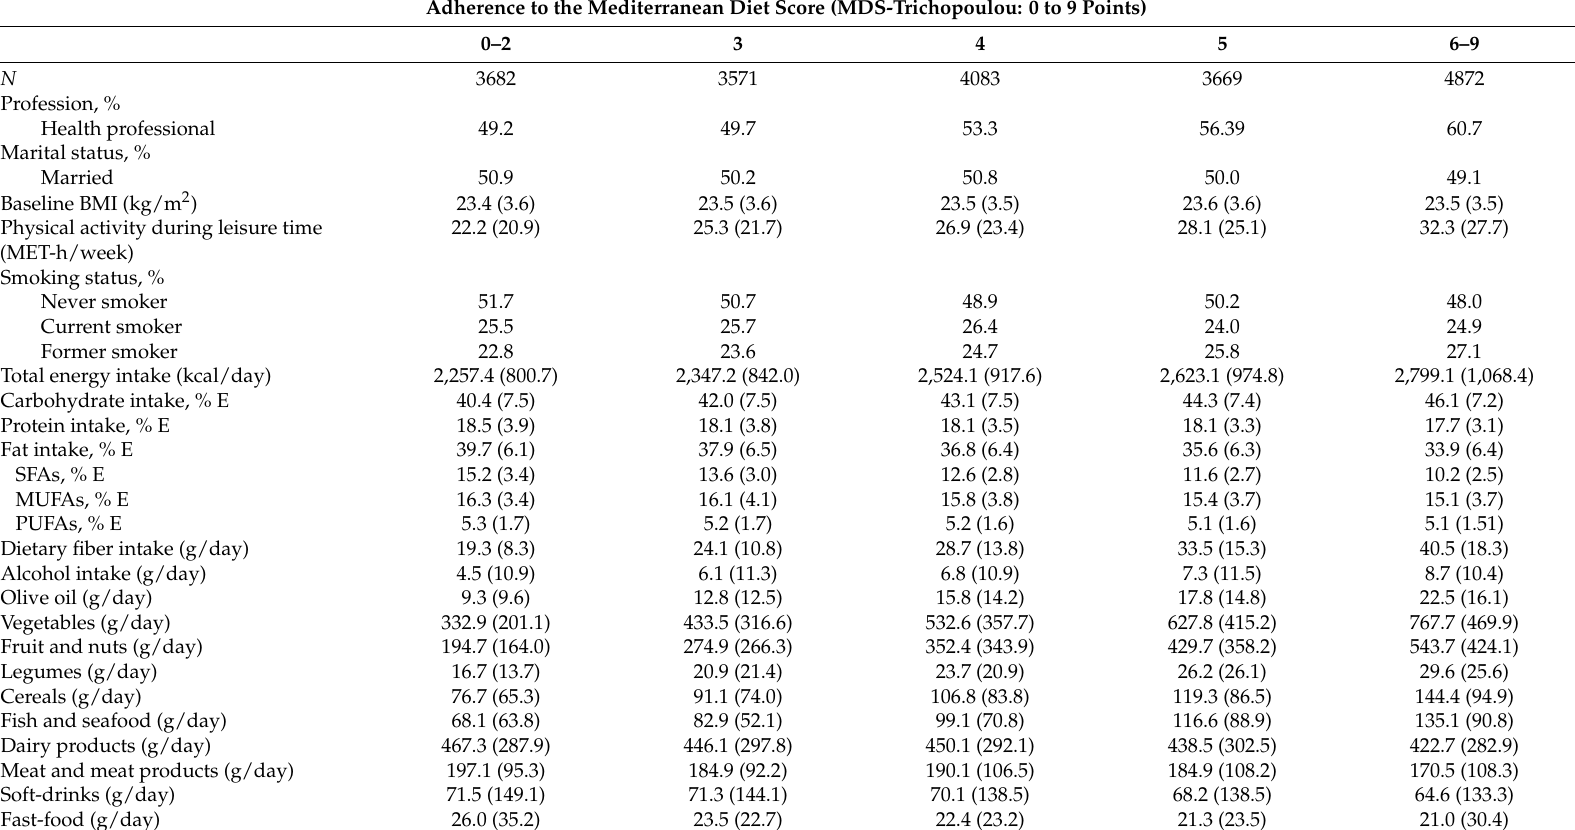
Table 2. Baseline characteristics of participants according to quintiles of adherence to the Mediterranean diet (MedDiet) in the SUN Project 1